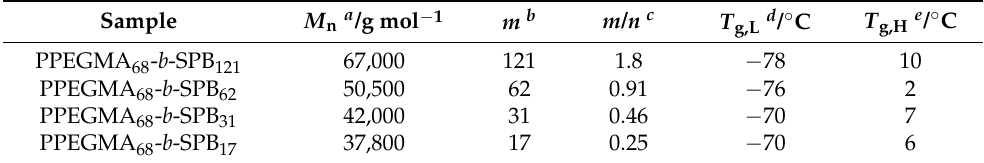
Table 1. Molecular Weights ( M n ) and Glass Transition Temperatures ( T g ) of PPEGMA 68 - b -SPB m . Sample